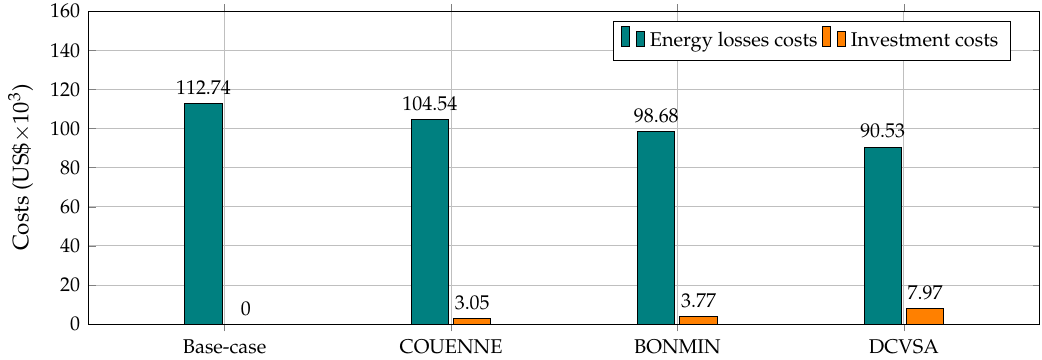
Figure 3. Distribution of the operative and investment costs for the comparative and proposed approach.